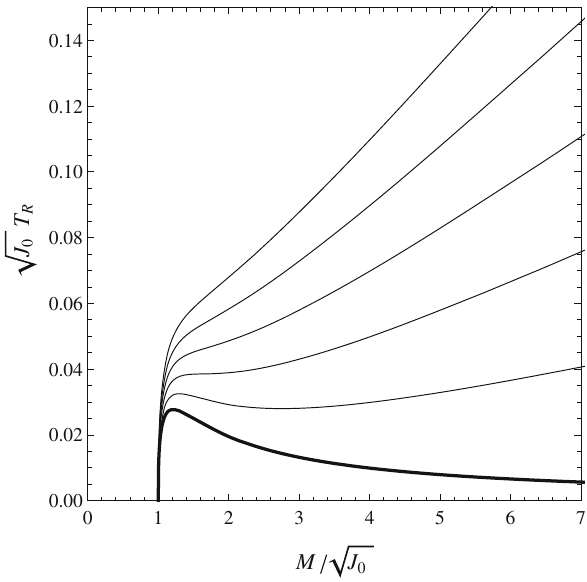
Fig. 2 Phase diagram of Kerr black holes with Rényi entropy. On the dashed curve C JR diverges while on the dotted curve C Ω R diverges. In region I, C Ω R < 0 and C JR < 0, in region II, C Ω R < 0 and C JR > 0, while in region III, C Ω R > 0 and C JR > 0